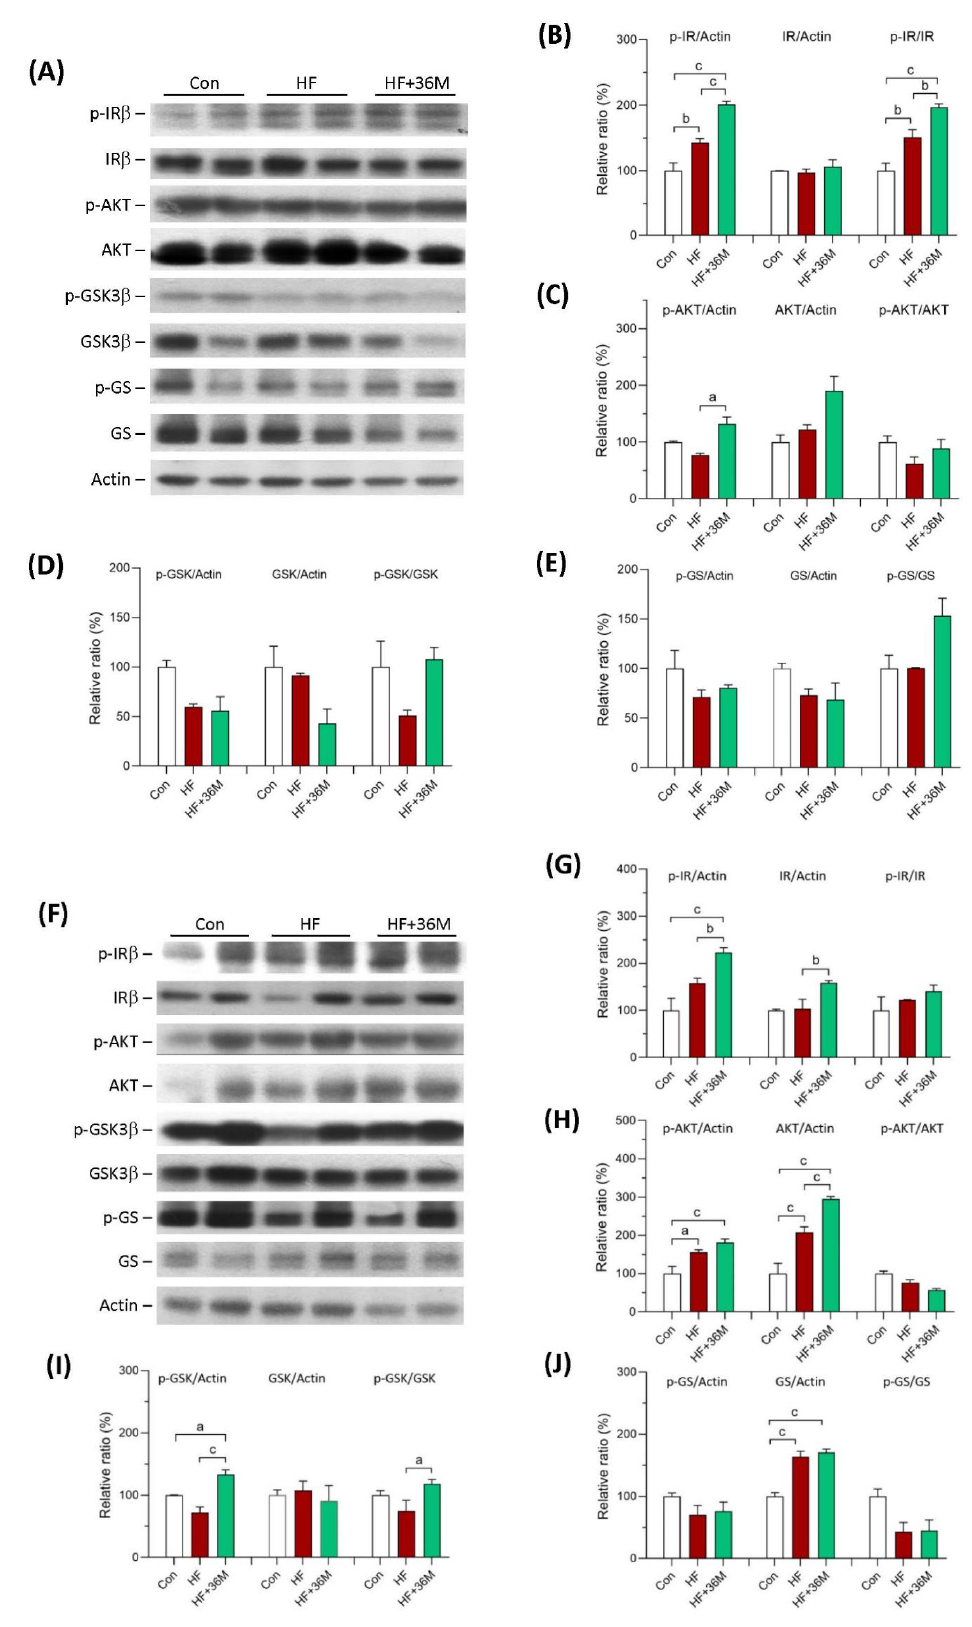
Figure 6. Protein expression of IR β , AKT, GSK3 β , and GS in skeletal muscle of the mice. ( A ) The representative immunoblot images for phosphorylated insulin receptor β subunit (p-IR β ), IR β , phosphorylated AKT (p-AKT), AKT, phosphorylated GSK3 β (p-GSK3 β ), GSK3 β ,